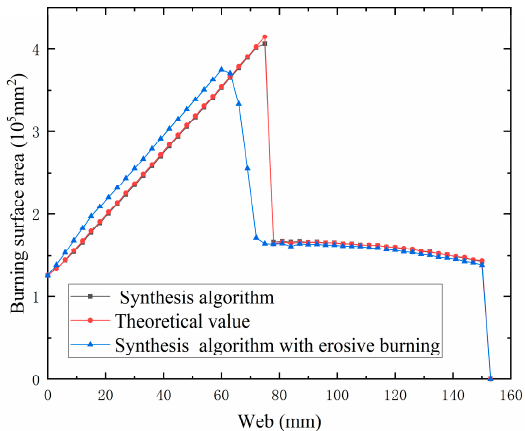
Figure 14. Burning process of double burning-rate tube grain.